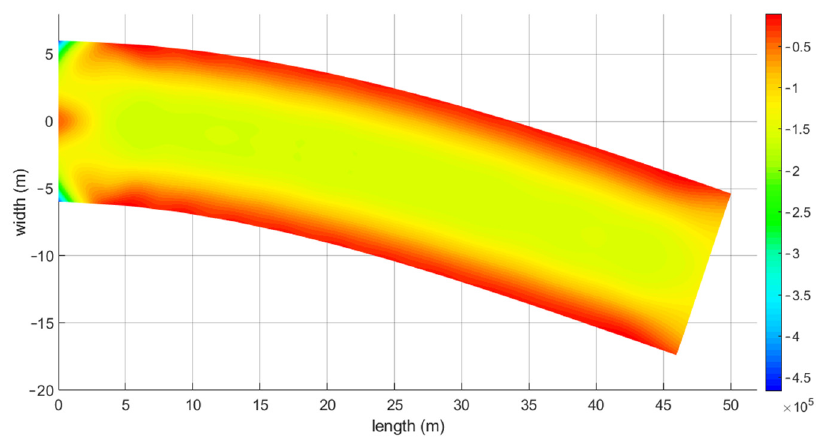
Figure 26. Shear stress τ xy of the cantilever beam (t = 0.4 s), with time-dependent damping.